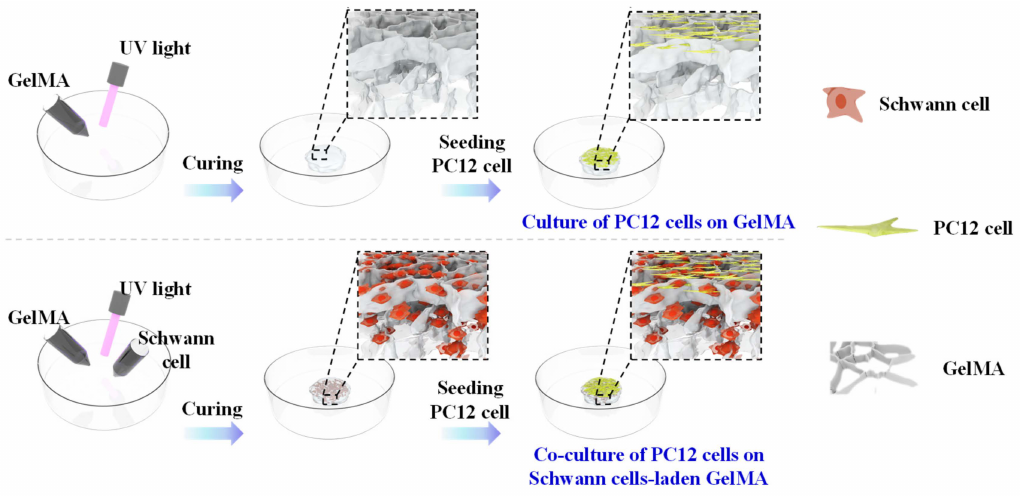
Figure 7. The schematic diagram of co-culture